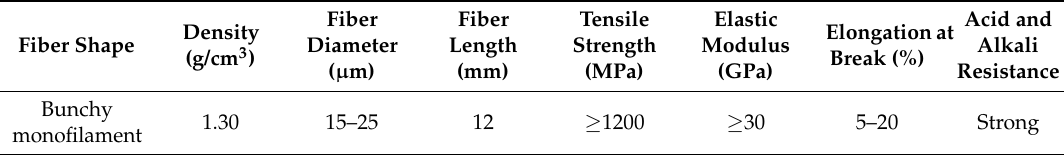
Table 1. Physical and mechanical parameters of polyvinyl alcohol (PVA)